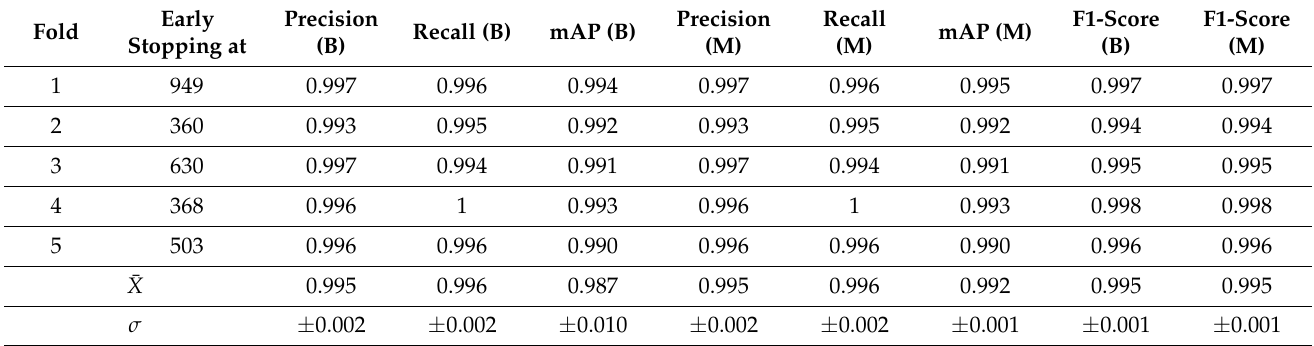
Table 5. Results for YOLOv5n model.